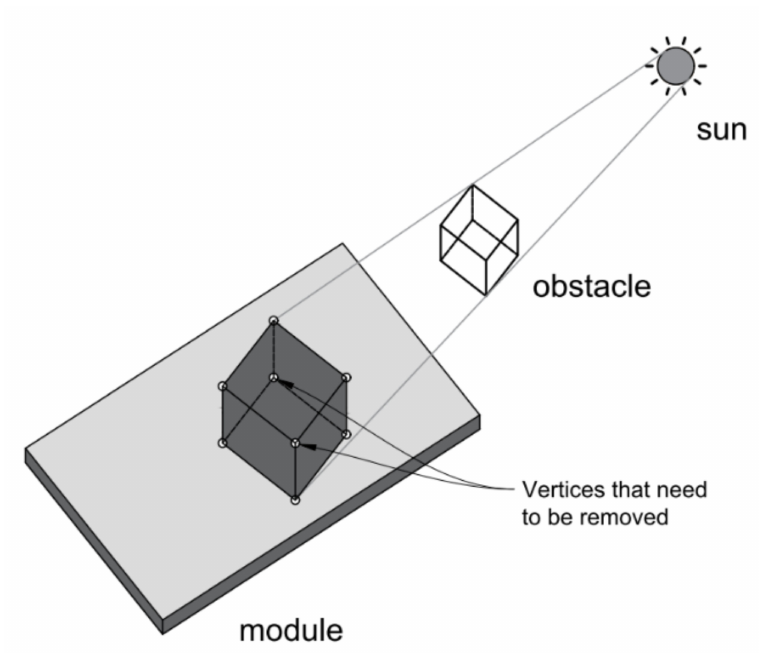
Figure 6. Projection of each of the eight obstacle vertices onto the surface of the module. After projecting all the points, there are two points that need to be removed. These two points are internal to the shadow and do not correspond to the ones located on the perimeter of the shadow.